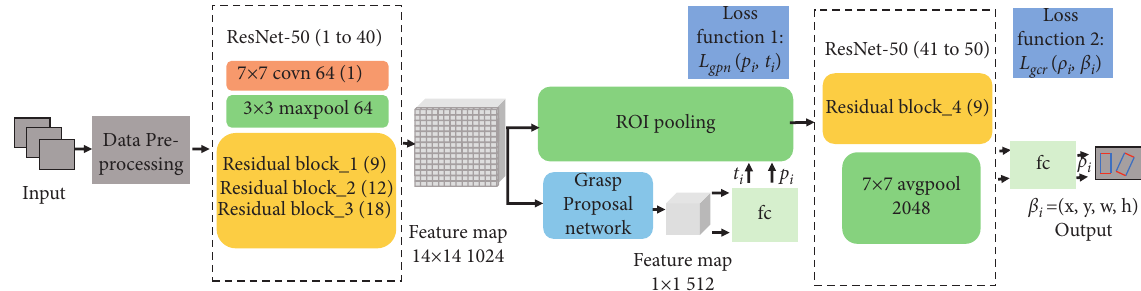
Figure 3: The structure of our network. The network uses RG-D images as inputs and predicts multiple grasp rectangles which contain position information, orientation information, and grasp quality score for each object. The data preprocessing part fuses the RGB image and the corresponding depth image to be the RG-D image and crops the RG-D image into a given size. The 1–40 layers of our network extract a feature map, the feature map is then fed into the Grasp Proposal Network and the ROI pooling. The rest of the network (41–50 layers) receives the output of the Grasp Proposal Network and generates several grasp